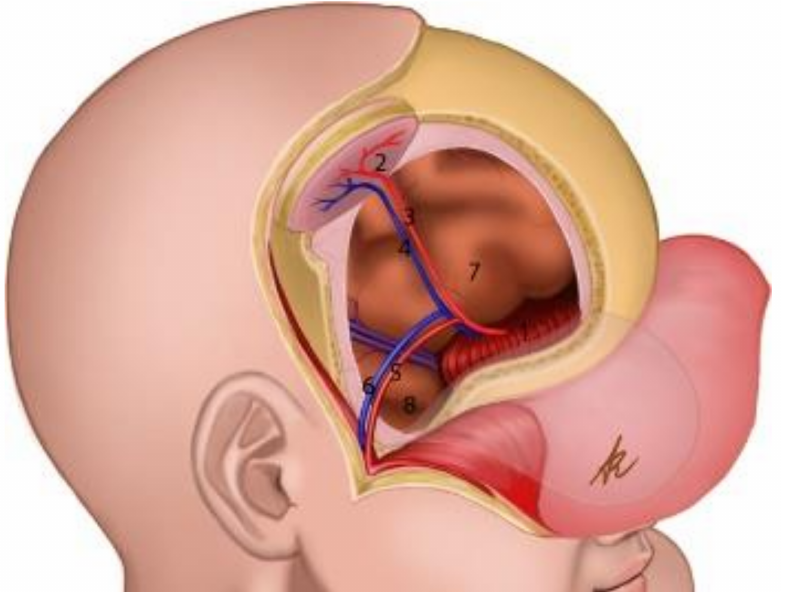
Figure 7. Schematic representation of the reconstruction. (1): Rectus femoris graft reconstructing the anterior cranial fossa; (2): adipocutaneous thigh paddle as the “skin island” of the chimeric flap; (3,4): arterial db-LCFA musculocutaneous (vastus lateralis muscle) perforator of the chimeric flap; (5,6): parietal branch of Superficial Temporal Artery (STA) and its comitantes veins; (7): frontal lobe; (8): temporal